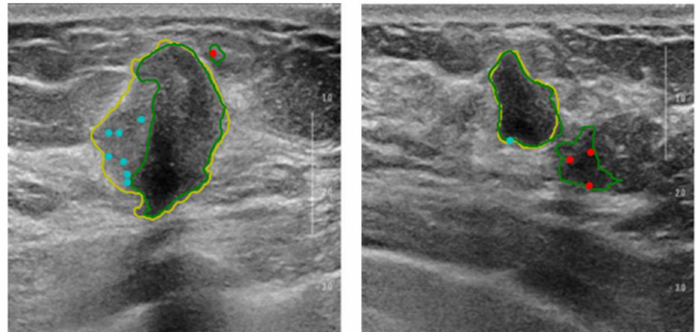
Figure 3. Examples of simulated interaction points in the training phase. The yellow and green lines are the contours of the ground truth and the previous segmentation, respectively. The cyan and red points are foreground and background interaction points, respectively.